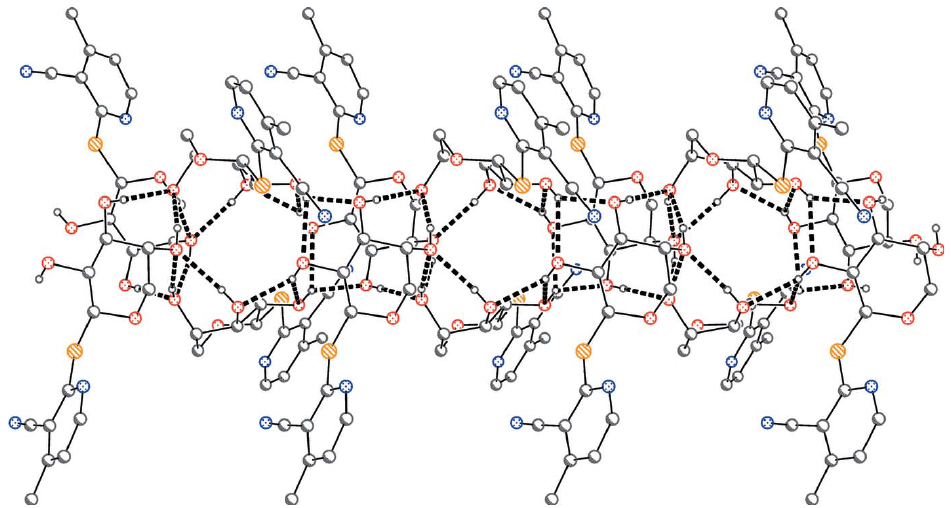
Figure 3 Packing diagram of ( 4 ) viewed parallel to the a axis. Dashed lines indicate classical hydrogen bonds. Phenyl rings are represented by the ipso carbon atoms only.